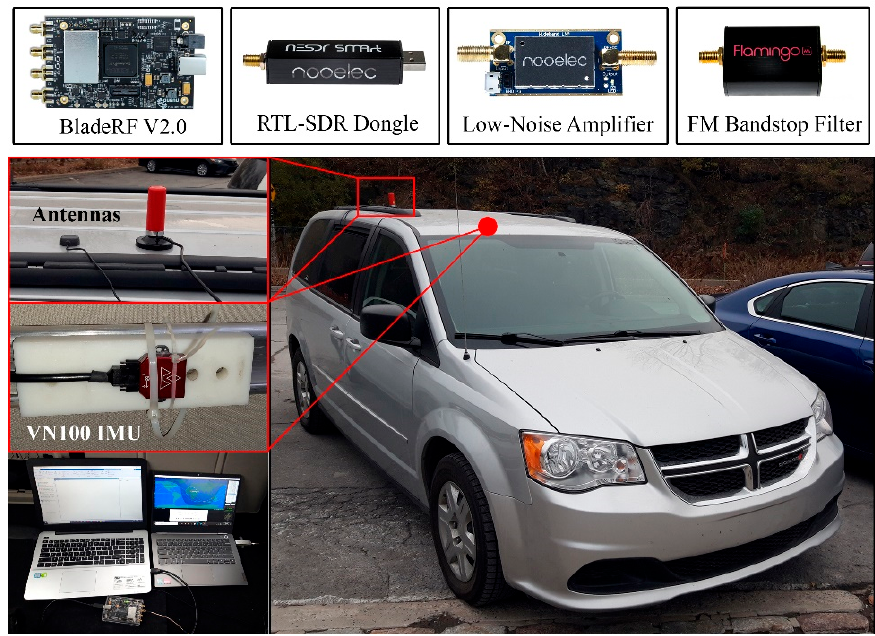
Figure 4. The ground vehicle and the equipment used in the ground experiment.